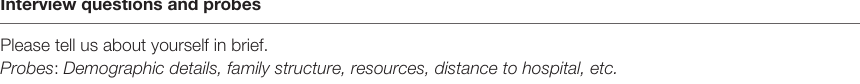
TABLE 1 | Focus group discussion and in-depth interview guide. Interview questions and